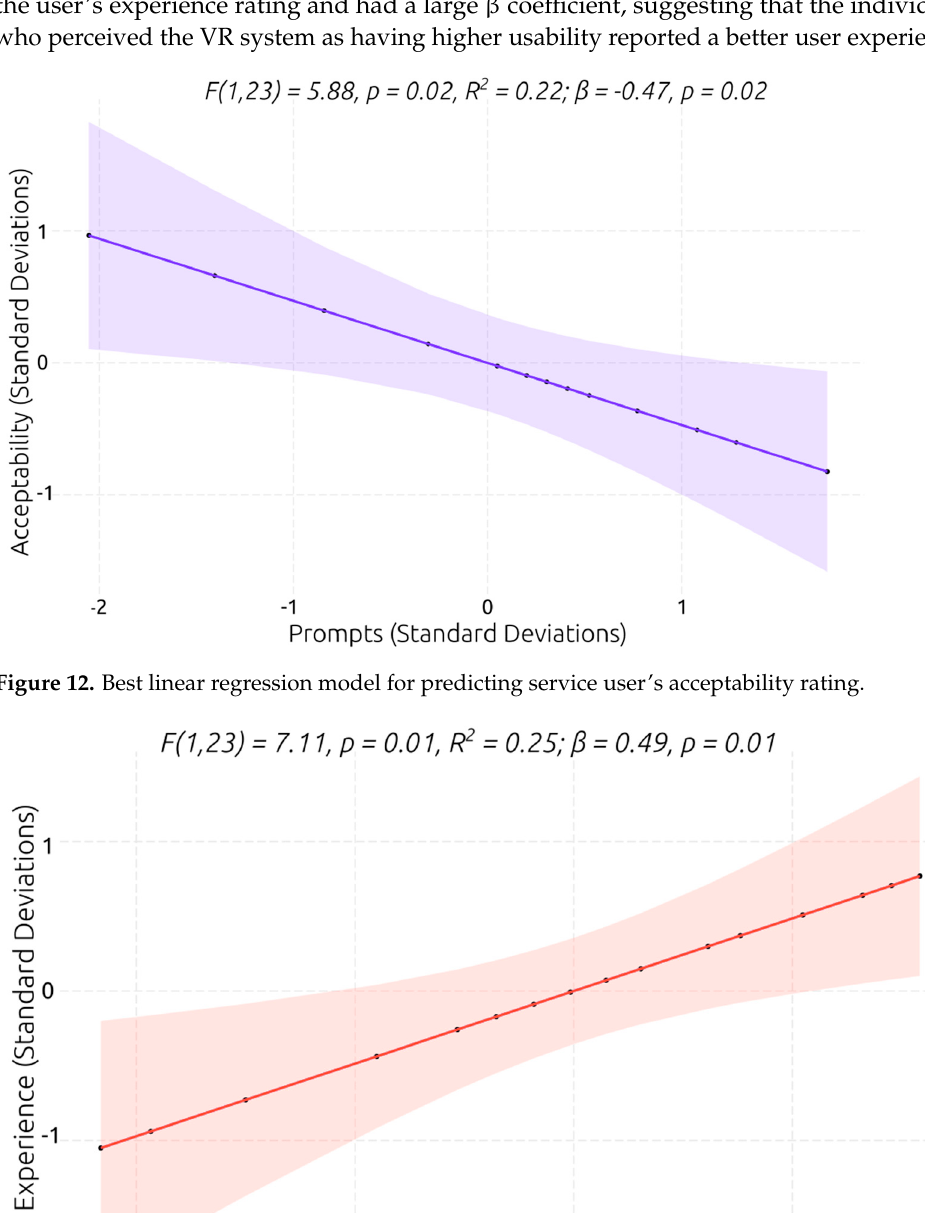
Figure 13. Best linear regression model for predicting user’s experience.